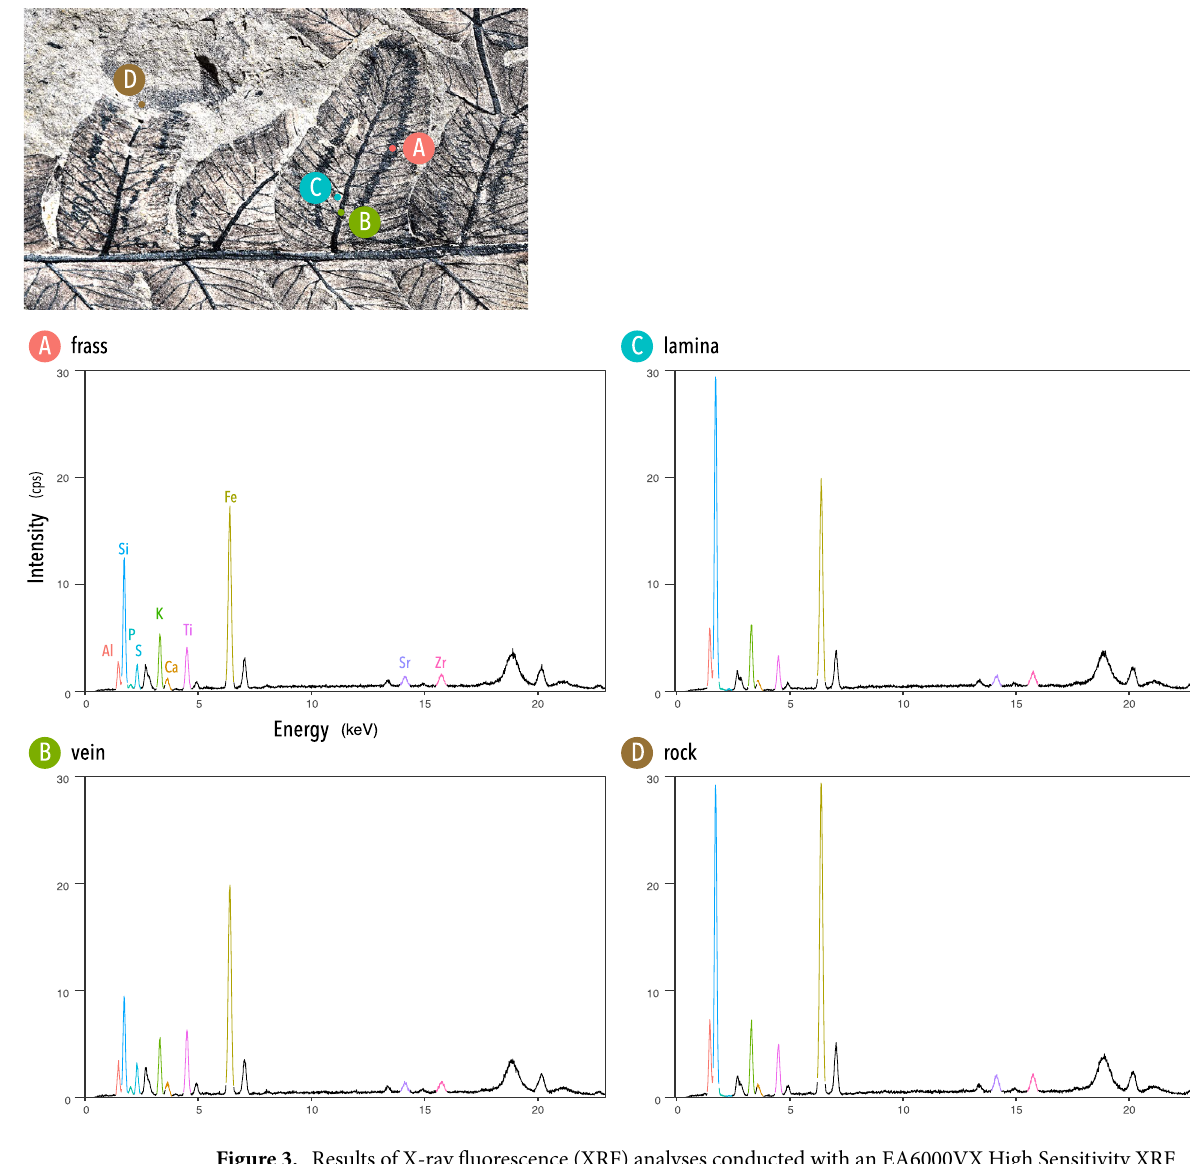
Figure 3. Results of X-ray fluorescence (XRF) analyses conducted with an EA6000VX High Sensitivity XRF Analyzer (Hitachi High-Tech Science Corporation). (Upper panel) Positions of the four sample points are specified on the specimen. (Lower panels) XRF spectra in the range of 0–23 keV illustrated for each sample point ( A – D ). Vertical axes signify cps (X-ray counts per and obtuse apices; veins catadromous, having distinct primary vein reaching apical margin and 11–13 secondary veins forking once. This species may alternatively be Todites fukutomii Kimura et Ohana 52 , but this possibility is not considered here because some distinguishing characters (e.g., fertile pinnules and twice-forked secondary veins) are lacking in our specimen. Remarks. The focal Cladophlebis frond is targeted by external foliage feeders in addition to miners. Excisions bordered by evident reaction rims (the area defined by two yellow asterisks in Fig. 2A) indicate signs of external feeding by a mandibulate folivore. X-ray fluorescence (XRF) analyses. Elements were quantified at four sample points: (A) frass trail, (B) leaf vein, (C) leaf lamina, (D) rock matrix (Fig. 3). The XRF spectrum detected peaks of ten elements (Al, Si, P, S, K, Ca, Ti, Fe, Sr, Zr); the other peaks were of Rh gas used for the analyses. The values for four elements composition might include that of rock beneath the lamina. The results for the leaf lamina generally showed a similar trend with that of rock; however, P and S, presumably of biogenic origin, were detected, confirming that leaf tissue was preserved on the rock. We report the results below as the total amount of X-ray per sec (cps).